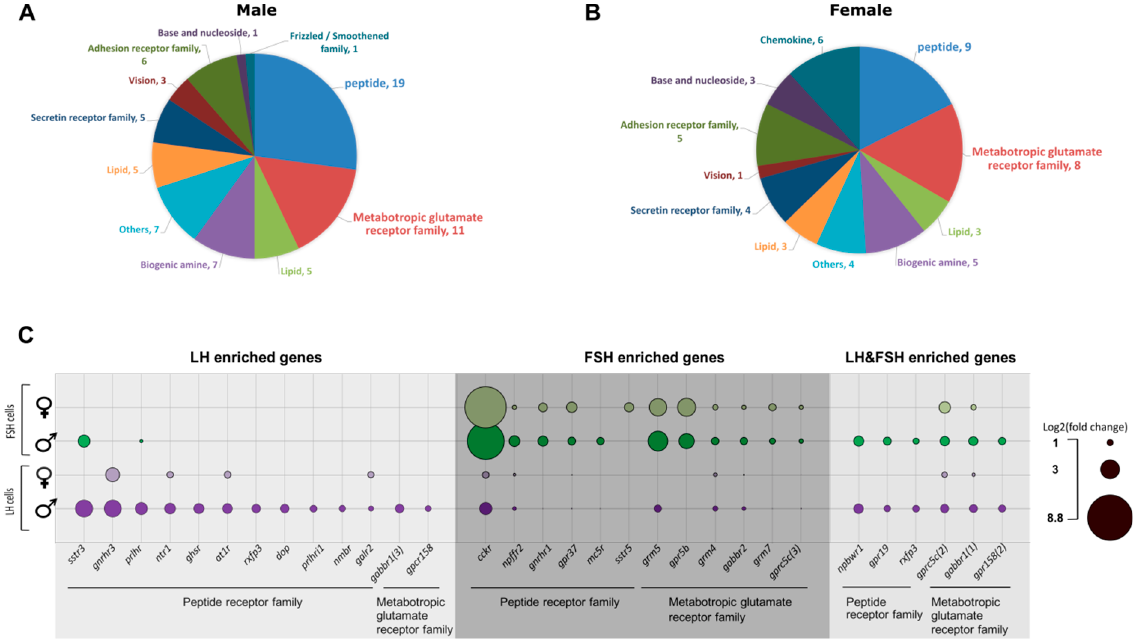
Figure 5. Enriched GPCRs in LH and FSH cells. ( A , B ) Pie charts describing the number of genes in each GPCR family that are enriched in the gonadotrophs of males ( A ) and females ( B ) according to BRIT annotation. The two GPCR families with highest number of genes are the peptide receptors family and the metabotropic glutamate receptor families. Supplementary Tables S4 and S5 contain detailed information of the genes in all identified GPCR families. ( C ) A bubble plot revealing the log2(fold change) expression of GPCRs from the peptide and metabotropic glutamate receptors families. Genes were divided to LH enriched, FSH enriched, and LH and FSH enriched genes according to the clustergram analysis (Figure 3B,C). Each row represents the fold change of genes in the FSH (green) or LH (magenta) cells compared to the negative, in males or females respectively. Though GnRH is considered the main hormone regulating gonadotropins activity, this analysis reveals a complete repertoire of hormones regulating each gonadotroph in a specific manner, and in some cases they are thought to be more significant than GnRH as their fold expression is higher, such as CCK in FSH cells and SST in LH cells. The bubble plot was prepared using Excel and visualized in Inkscape.